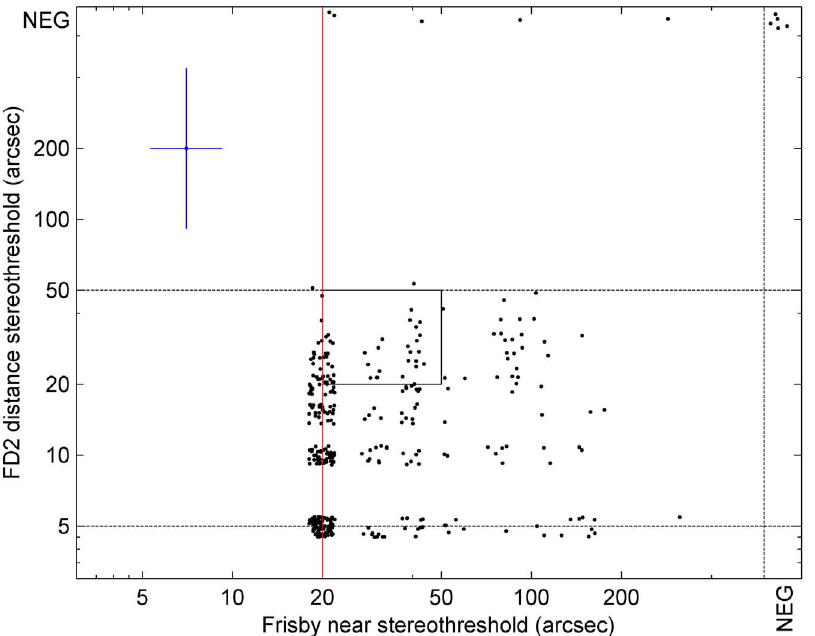
Figure 4. Scatterplot of stereothresholds measured on the revised FD2 against those measured on the Frisby, for all 365 participants. Participants who were stereonegative are plotted at a notional threshold of 700 arcsec. Since possible scores on both tests are quantized, we have jittered the data-points so they do not coincide: for purposes of plotting, each threshold was multiplied by a number between 0.9 and 1.1. The dashed lines indicate the floors and ceilings, i.e. the best and worst thresholds possible on each test. The central rectangle denotes the range of thresholds which were possible scores on both tests. For comparison, the blue cross indicates the 95% limits of agreement reported by Adams et al. [27] for the two tests, i.e. a factor of 1.74 for the near Frisby and 4,8 for the original FD2.